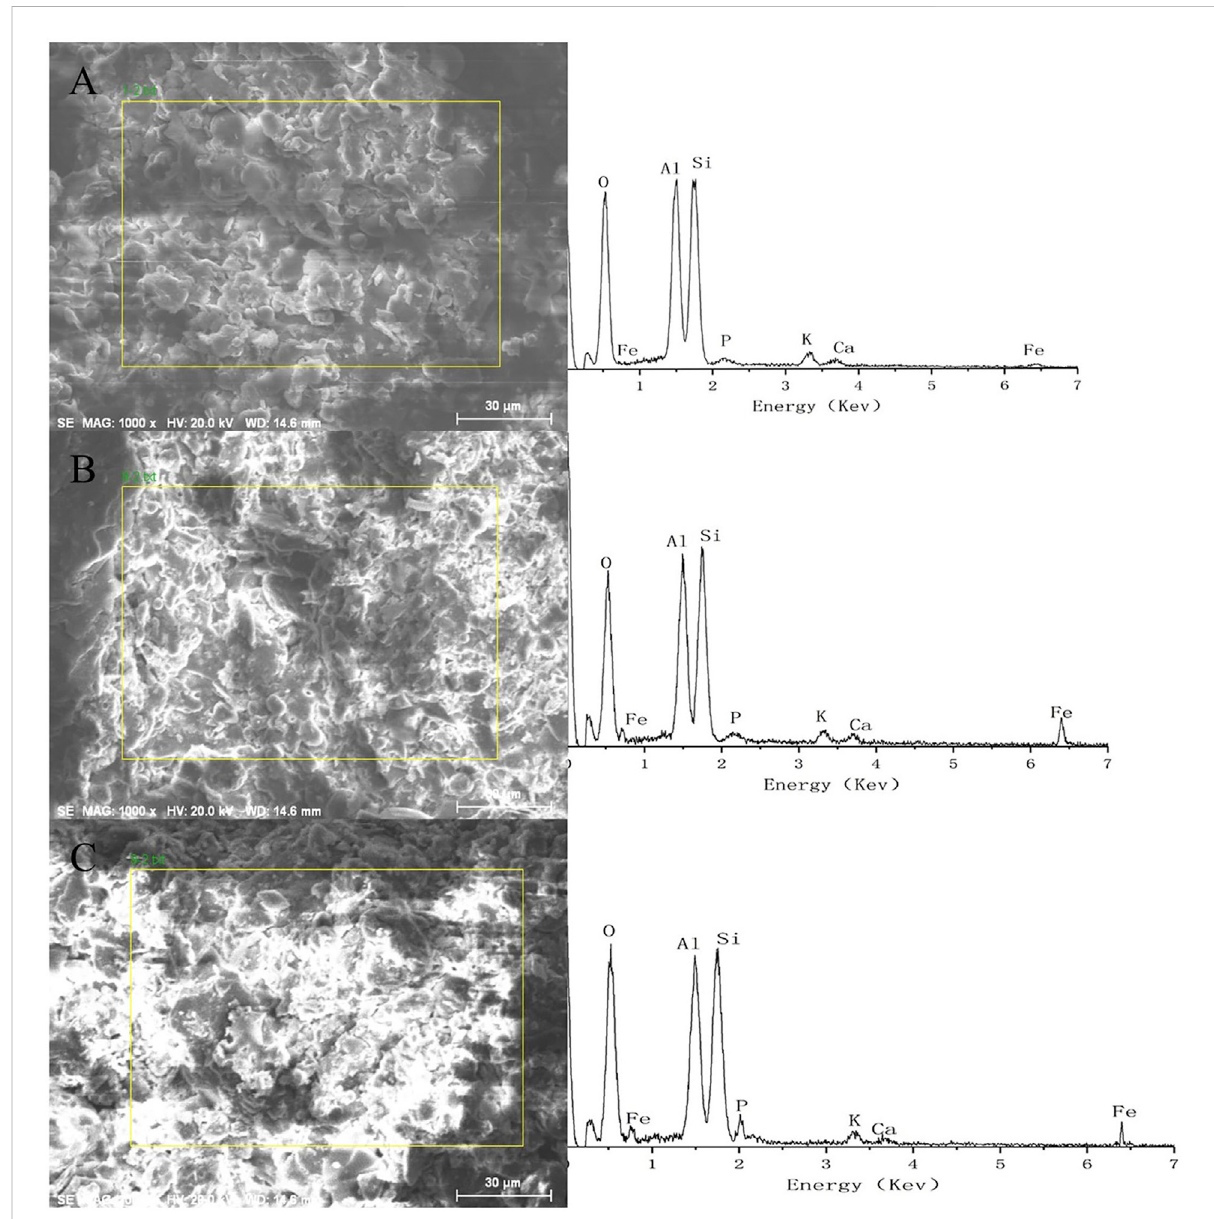
FIGURE 7 Comparison of energy spectrum analysis diagram before and after phosphorus adsorption (A) coal ash ceramsite unloaded with nano-iron; (B) coalashceramsiteloadedwithnano-ironbeforetheadsorptionofphosphorus; (C) coalashceramsiteloadedwithnano-ironaftertheadsorptionof